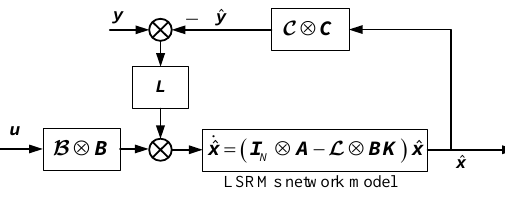
Figure 5. Observer structure.